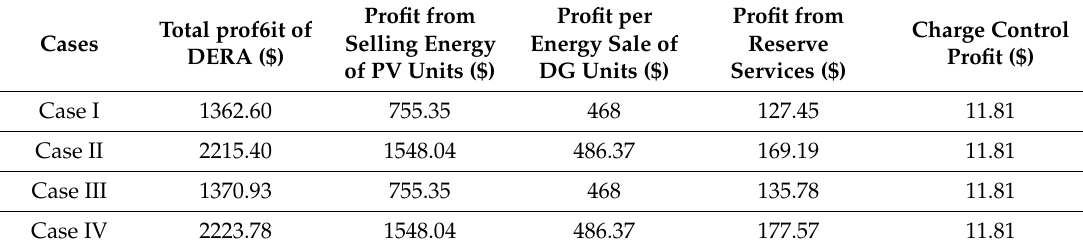
Figure 13. Minimum and maximum voltages for Cases III and IV. Table 3. Summary of the Aggregator’s Profit.